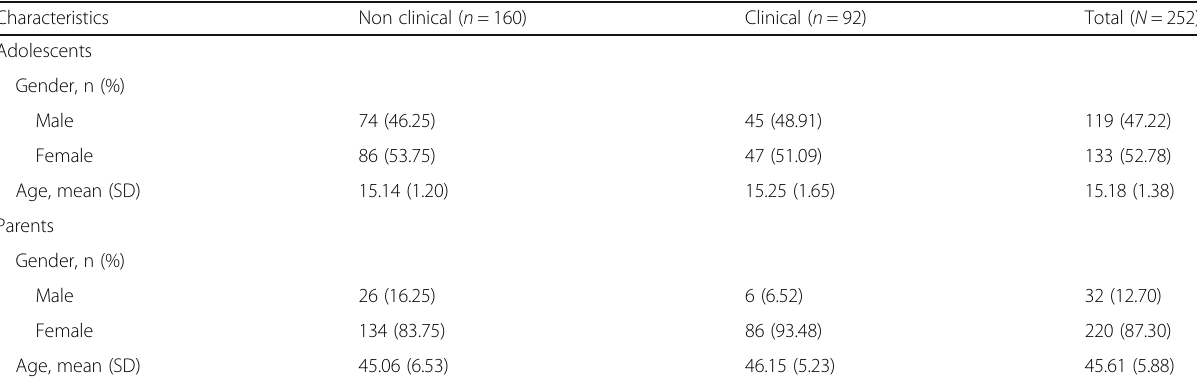
Table 1 Participant Characteristics Characteristics